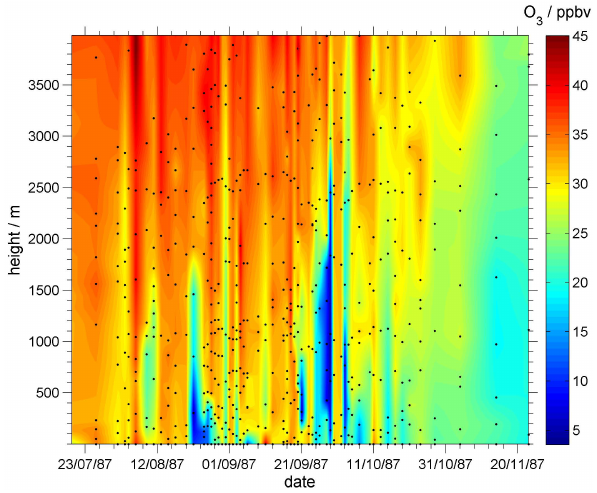
Fig. 9. Contour plot showing the vertical profile of tropospheric ozone against time derived from balloon-borne ozonesonde ascents during austral spring 1987. Tick marks are at 00:00 GMT every 4 days. Each dot indicates a measurement point; the irregular vertical grid is apparent, but so is the relatively good data coverage of ODEs.